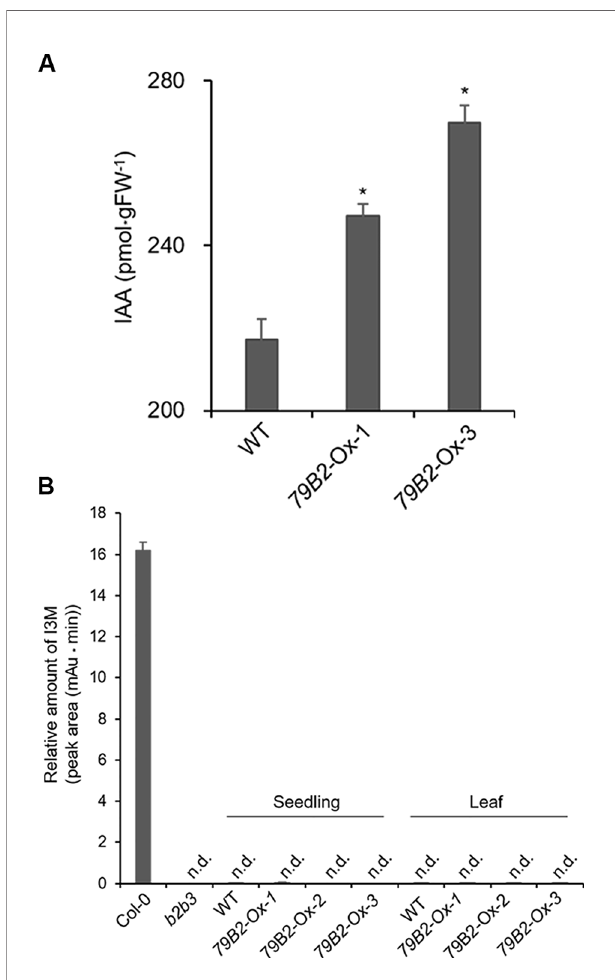
FIGURE 2 | The Levels of IAA are Increased but Indole Glucosiniolate is De fi cient in Camelina Transgenic Plants Overexpressing AtCYP79B2 . (A) Free IAA contents in the Camelina overexpression lines and wild type. Six-day-old seedlings grown on MS medium were collected for IAA measurement. Data represent mean ± SE of four independent experiments. * represents P < 0.05 (two-tailed student ’ s t-test) when compared with wild type. (B) Relative levels of indole-3-ylmethyl glucosinolate (I3M) in C. sativa and A. thaliana . The levels of I3M were measured from 6-day-old Camelina seedlings grown in MS medium or leaves from 8-week-old plants grown on soil. Arabidopsis Col-0 and cyp79b2 cyp79b3 ( b2b3 ) were used as positive and negative controls. Relative contents of I3M are shown based on peak areas of HPLC chromatograms at the retention time where I3M in Col-0 was eluted. Data represent mean ± SE of three independent experiments. n.d., not